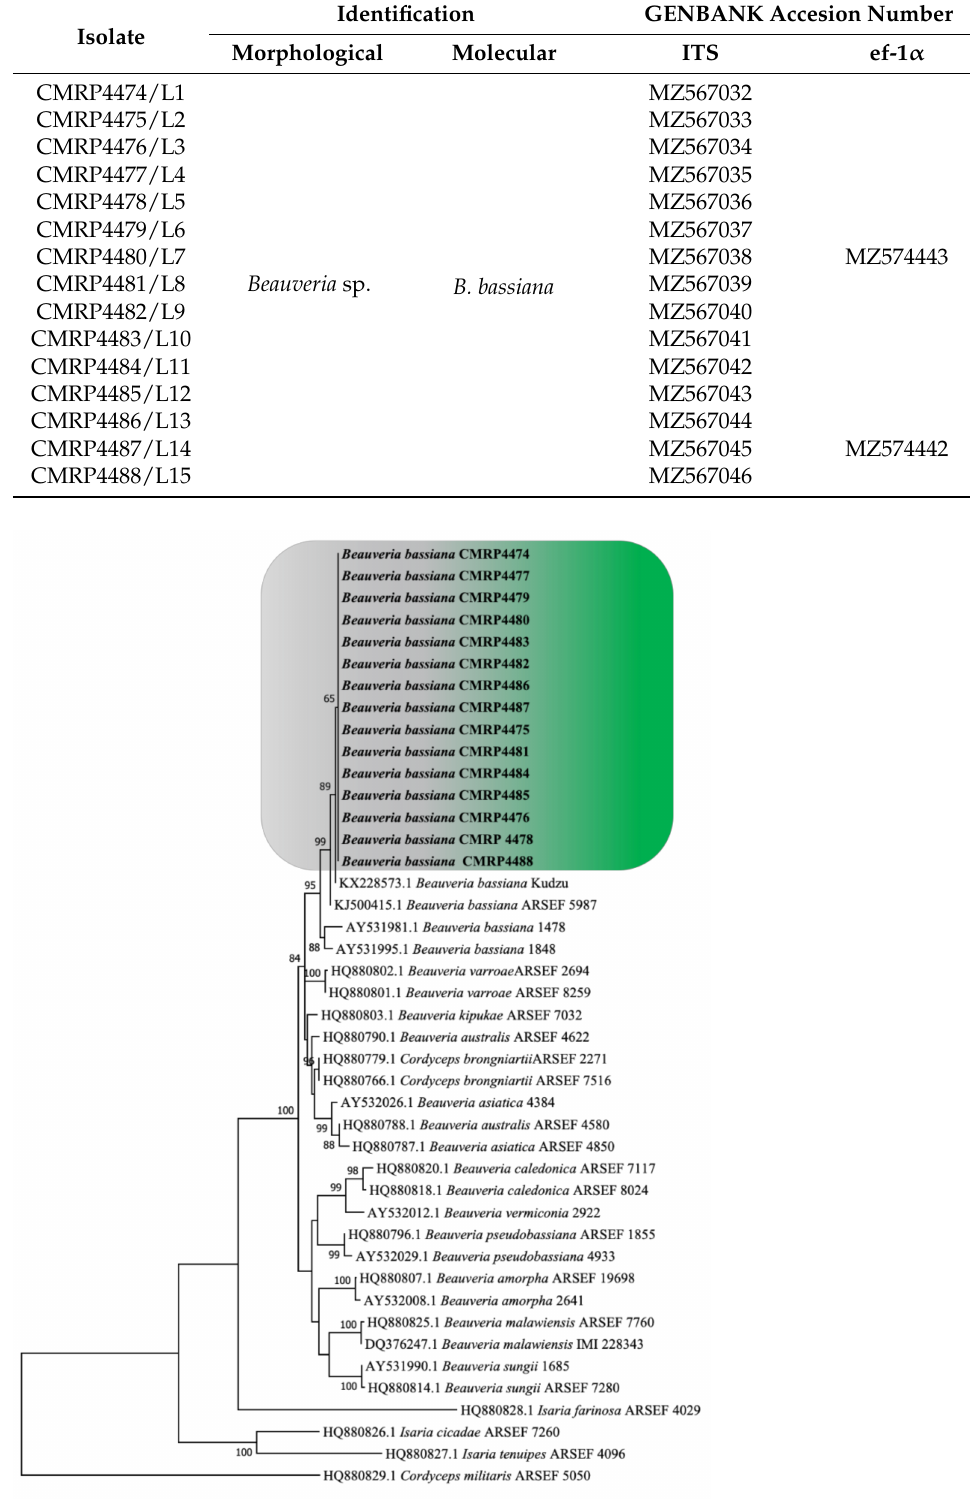
Table 1. Fungal strains, identified as Beauveria bassiana , isolated from Lema bilineata (Coleoptera: Chrysomelidae) adults collected in Campo Largo, Paran á , Brazil, and their GENBANK accession numbers.